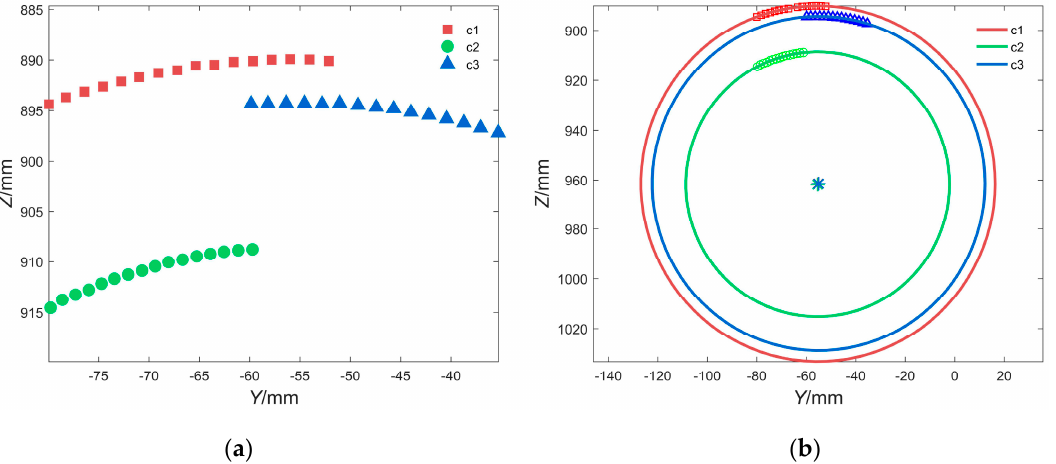
Figure 11. ( a ) Projection of the optical centers on the Y w O w Z w plane; ( b ) fitted circular curve. Table 3. Fitting results.